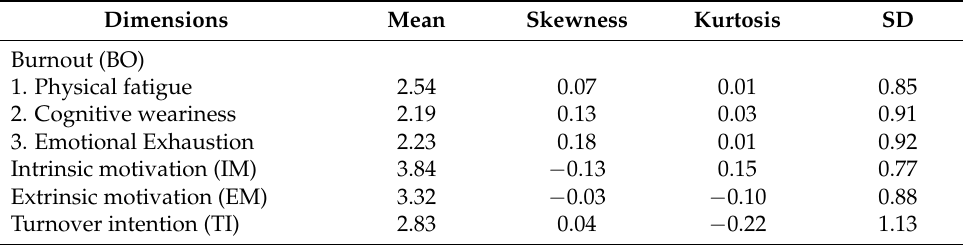
Table 2. Descriptive statistics of the latent